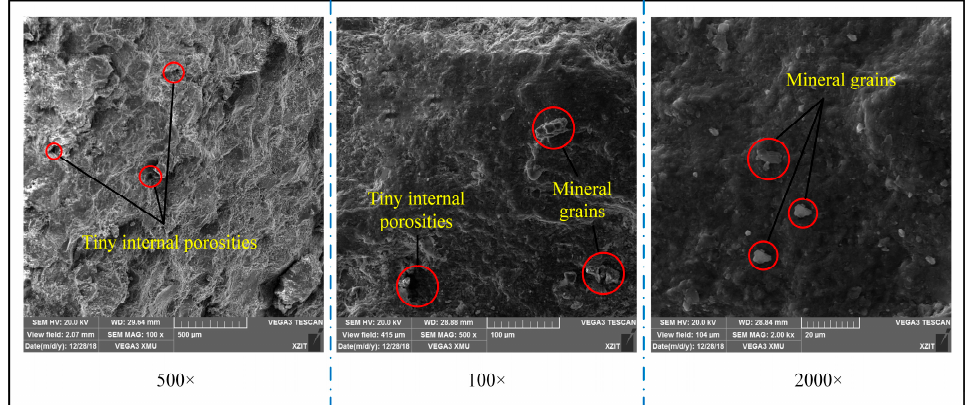
Figure 3. Scanning electron microscopy (SEM) analysis of sandstone.